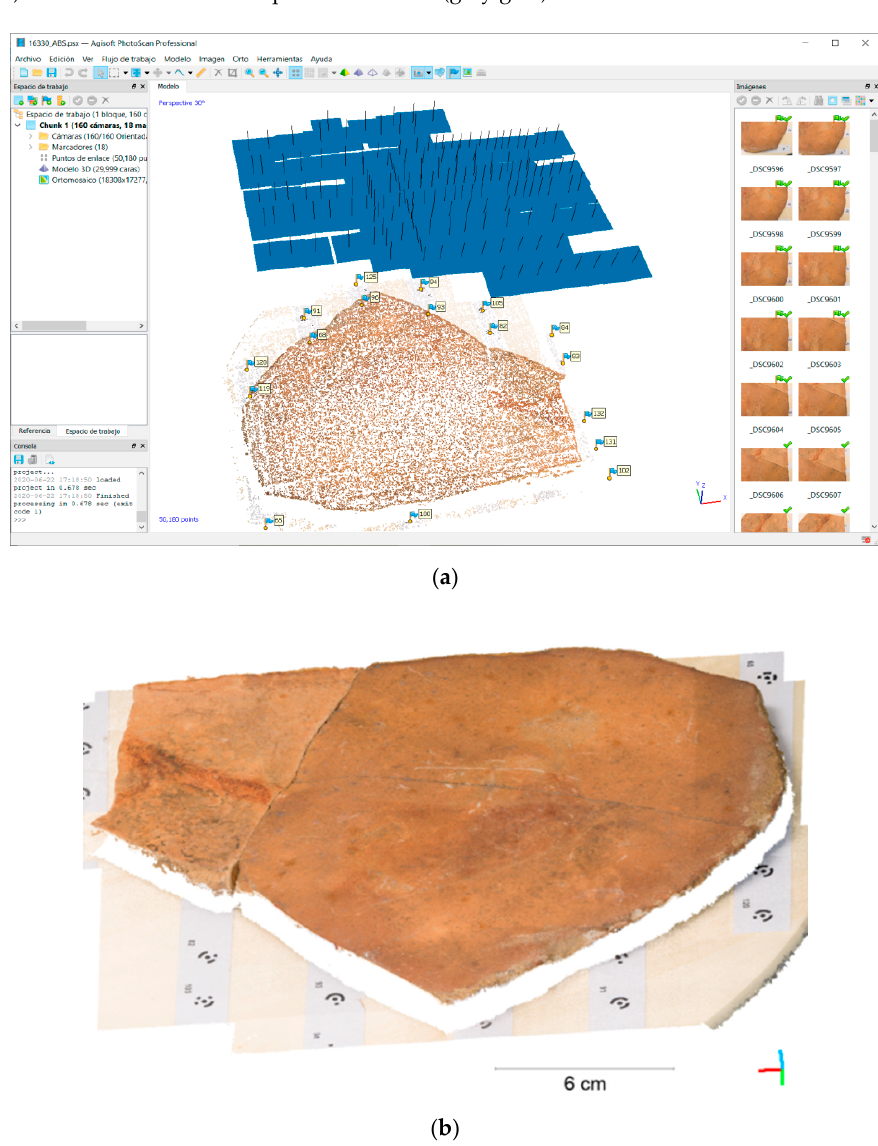
Figure 4. Agisoft PhotoScan project: ( a ) visualization of the XYZ points used for the adjustment, with the spatial positioning of each camera and the ground points used for the absolute orientation; ( b ) raw dense point